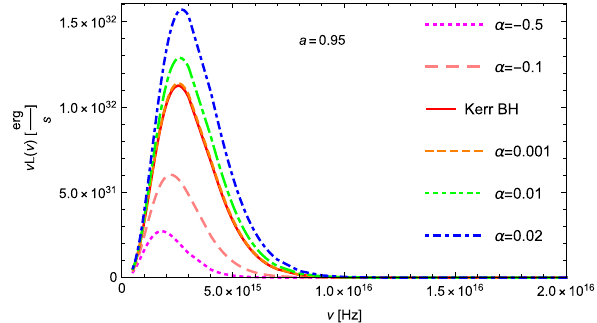
Fig. 8 The emission spectrum ν L (ν) of the accretion disk around a rotating 4 D EGB BH with mass accretion rate ˙ M ∼ 10 18 g s − 1 for different values of α , as a function of frequency ν . The solid curve represents the disk spectrum for a Kerr